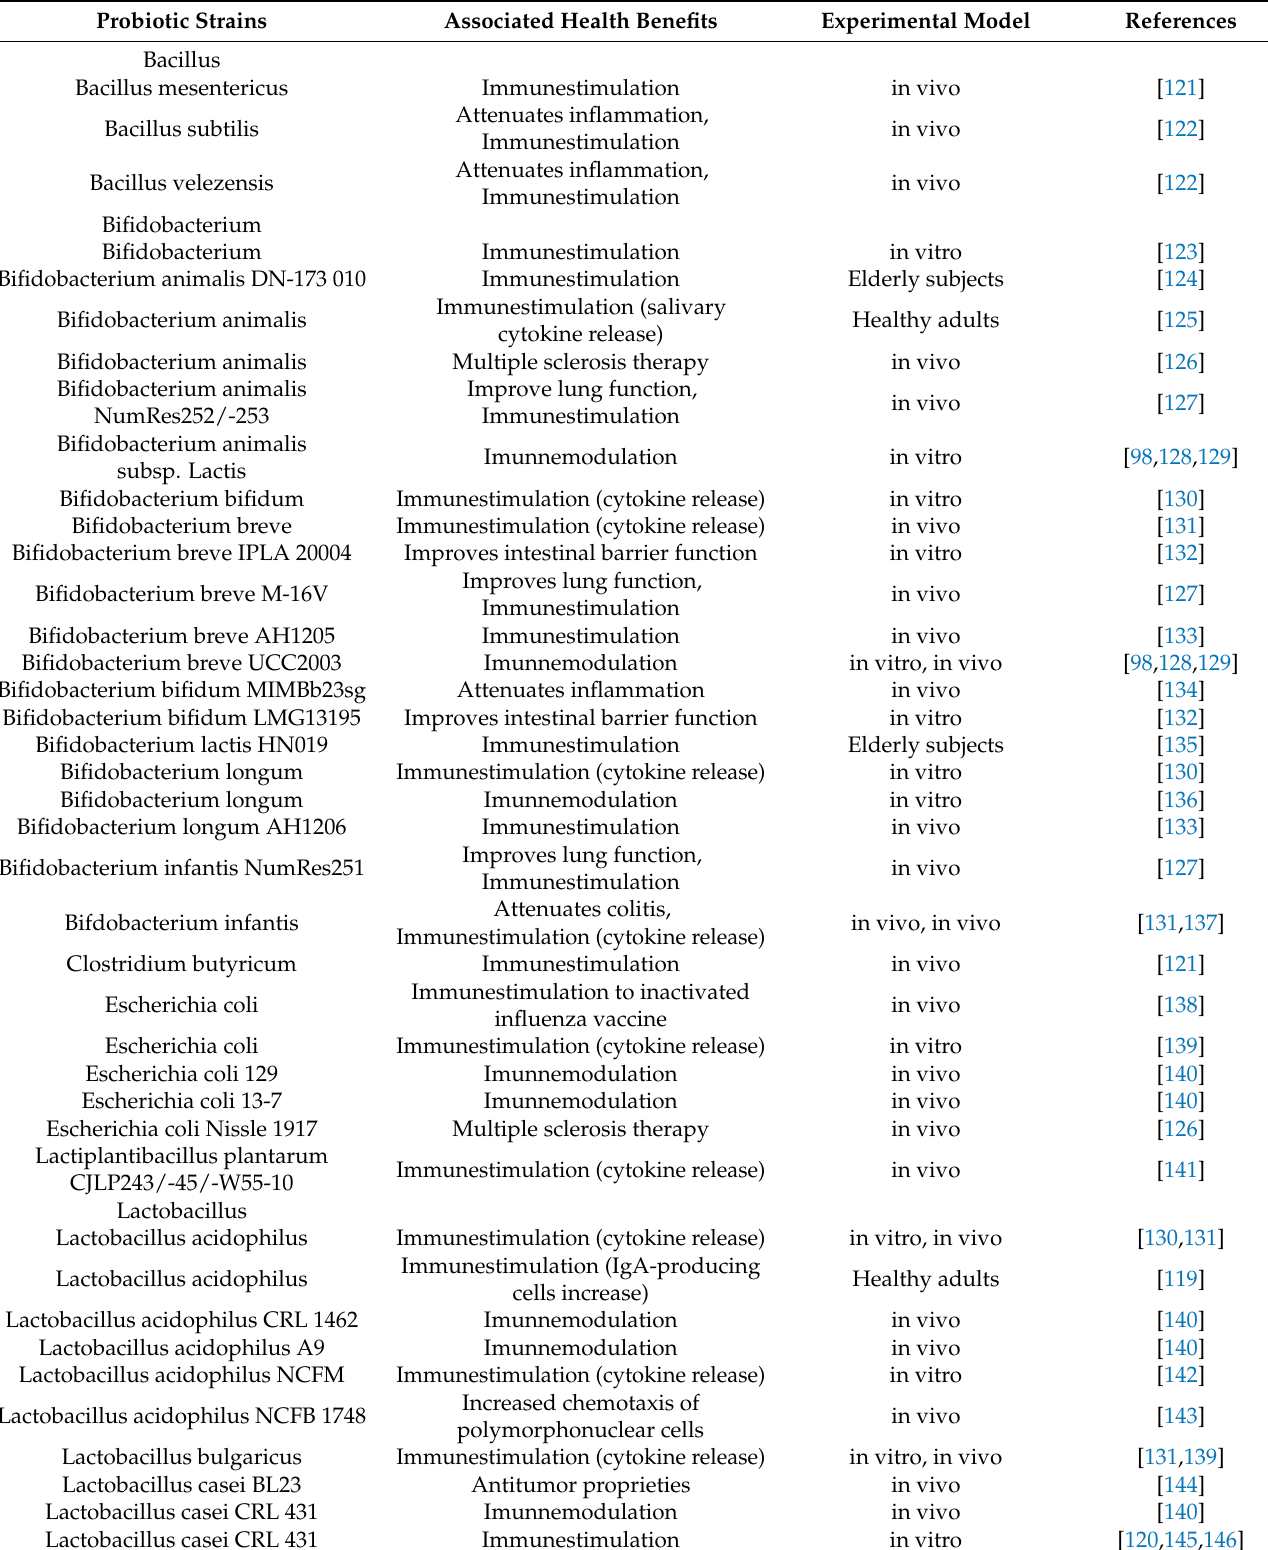
Table 1. Beneficial effects of probiotics reported in pre-clinical